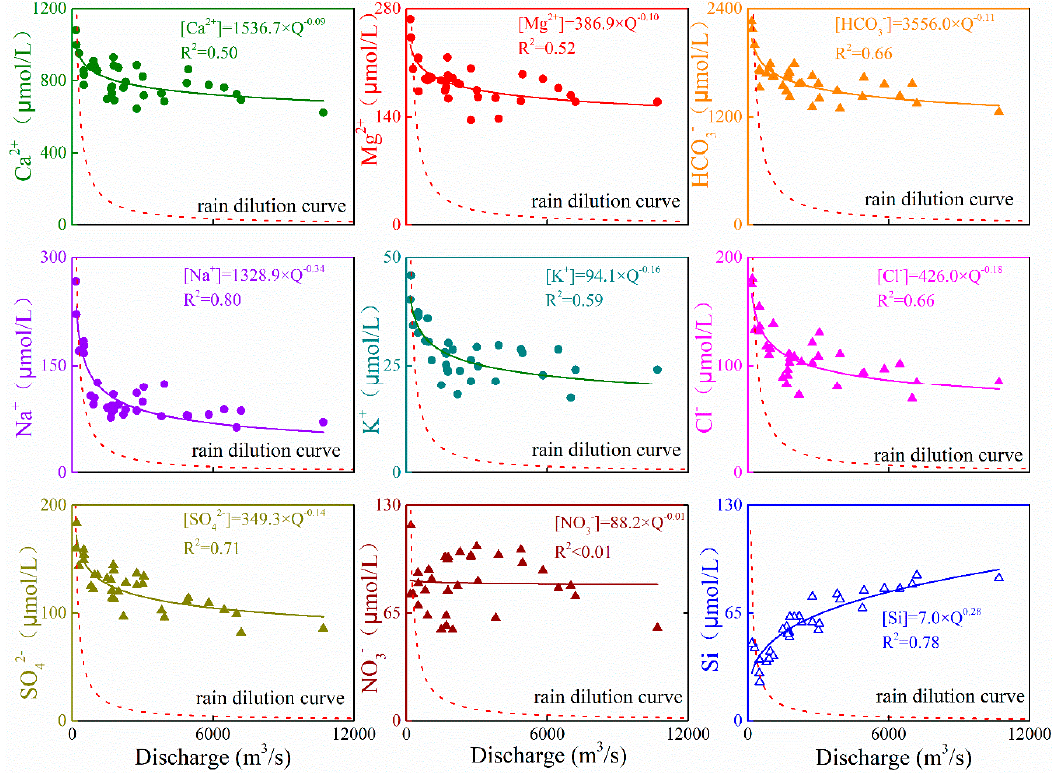
Figure 2. Riverine dissolved solutes content–discharge relationships in the Liujiang River.